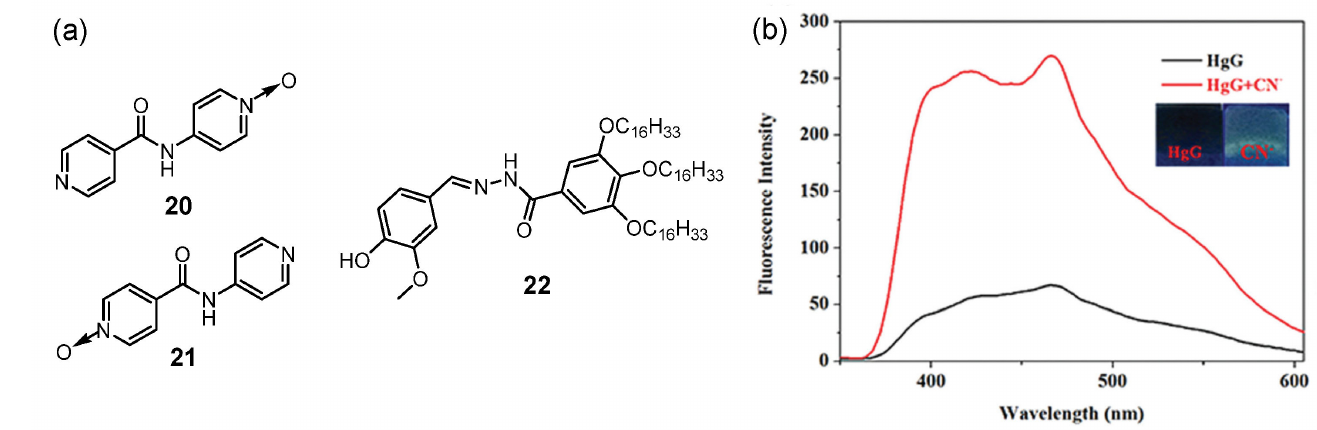
Figure 7. ( a ) Chemical structures of compounds 20 - 22 . ( b ) Change in the emission of the 22 · Hg 2+ gel (HgG) in the presence of CN − . The inset presents the color change of the 22 · Hg 2+ gel (HgG) in the presence of CN − . Reprinted with permission from Ref. [46]. Copyright (2019), Royal Society of